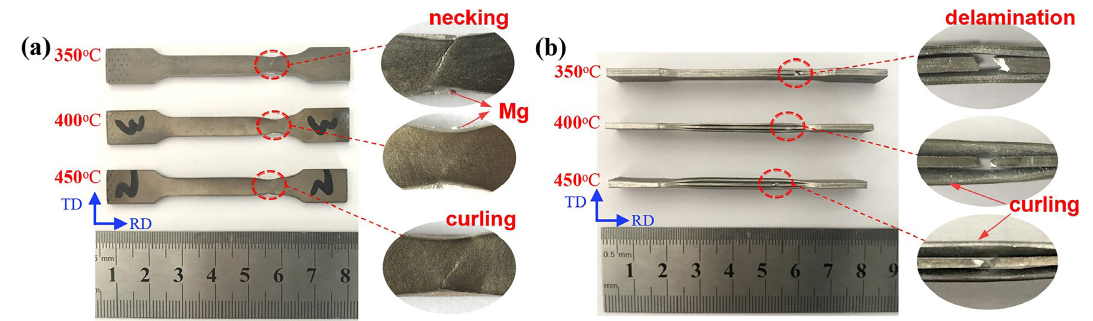
Figure 11. The macro morphologies of tensile specimens of LMCs after rupture at different hot-pressing temperatures: (a) RD-TD surface and (b) RD-ND